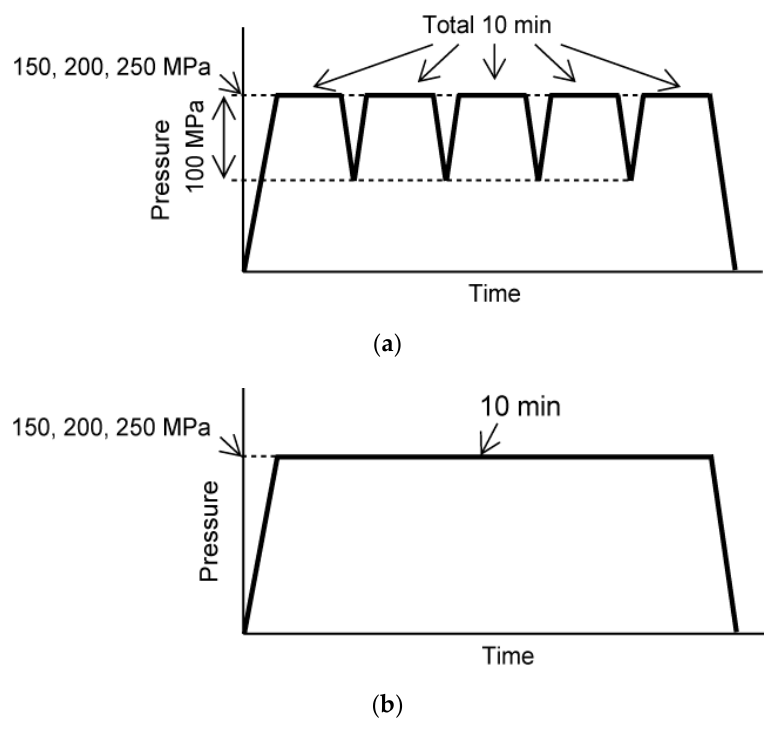
Figure 2. HHP displacement diagram applied to ( a ) cyclic and ( b ) static groups.